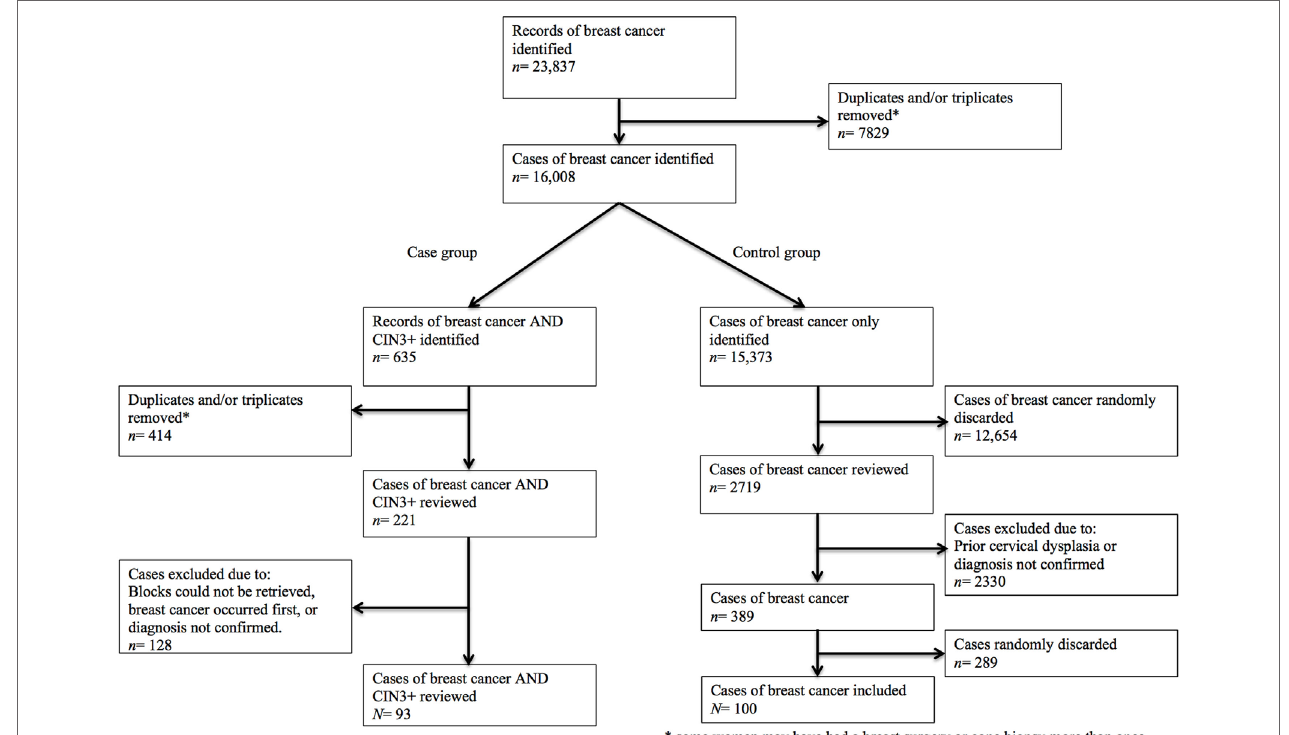
FigUre 1 | Flowchart of included